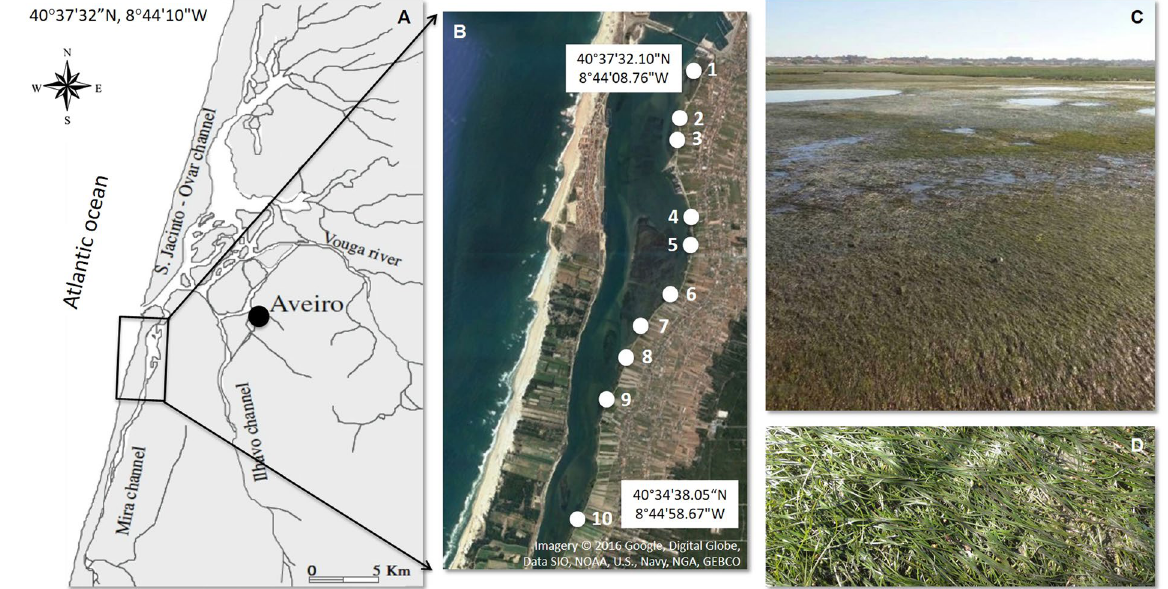
Figure 1. Mira channel at Ria de Aveiro coastal lagoon (Portugal) ( A , B ) sampling sites location (from site 1 (40°37 ′ 32.10 ″ N, 8°44 ′ 08.76 ″ W) to site 10 (40°34 ′ 38.05 ″ N, 8°44 ′ 58.67 ″ W)). ( C ) – Z . noltei meadow overview at the sampling site 5; ( D ) – Z . noltei detail. Map generated with ArcGIS 10, (http://www.esri.com/software/arcgis). Credits of World Terrain Base: Esri, USGS, NOAA, DeLorme, NPS. Mira channel side scheme adapted